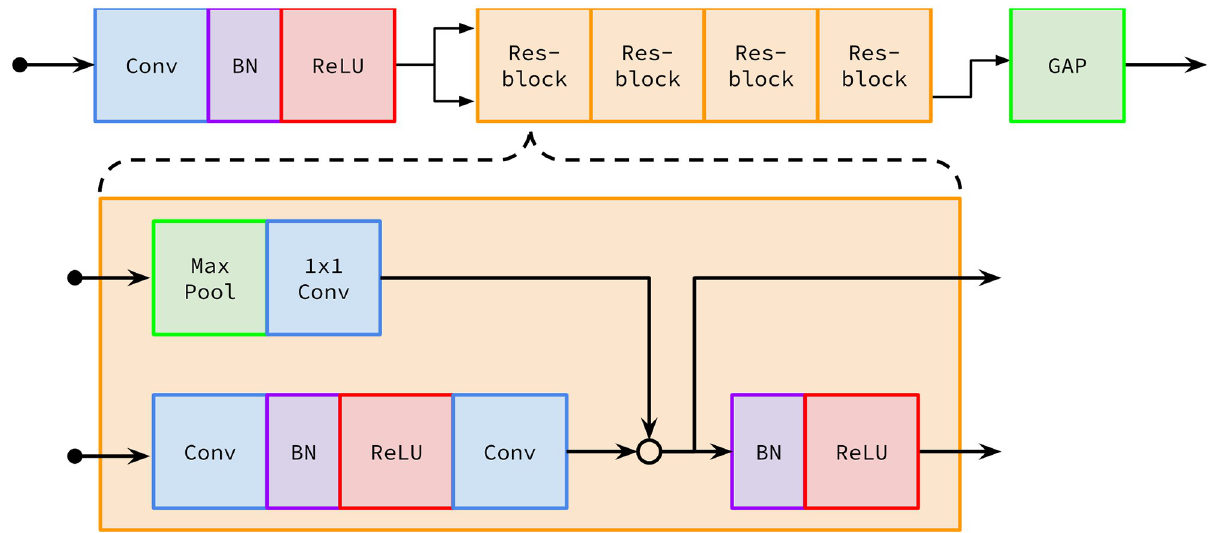
Fig 4. The ECG encoder architecture. Designed by [8] with modifications including global average pooling (GAP). Conv means 1D convolution, BN means batch normalization, Max Pool means 1D max pooling, ReLU means rectified linear unit, and Res-block means residual block.